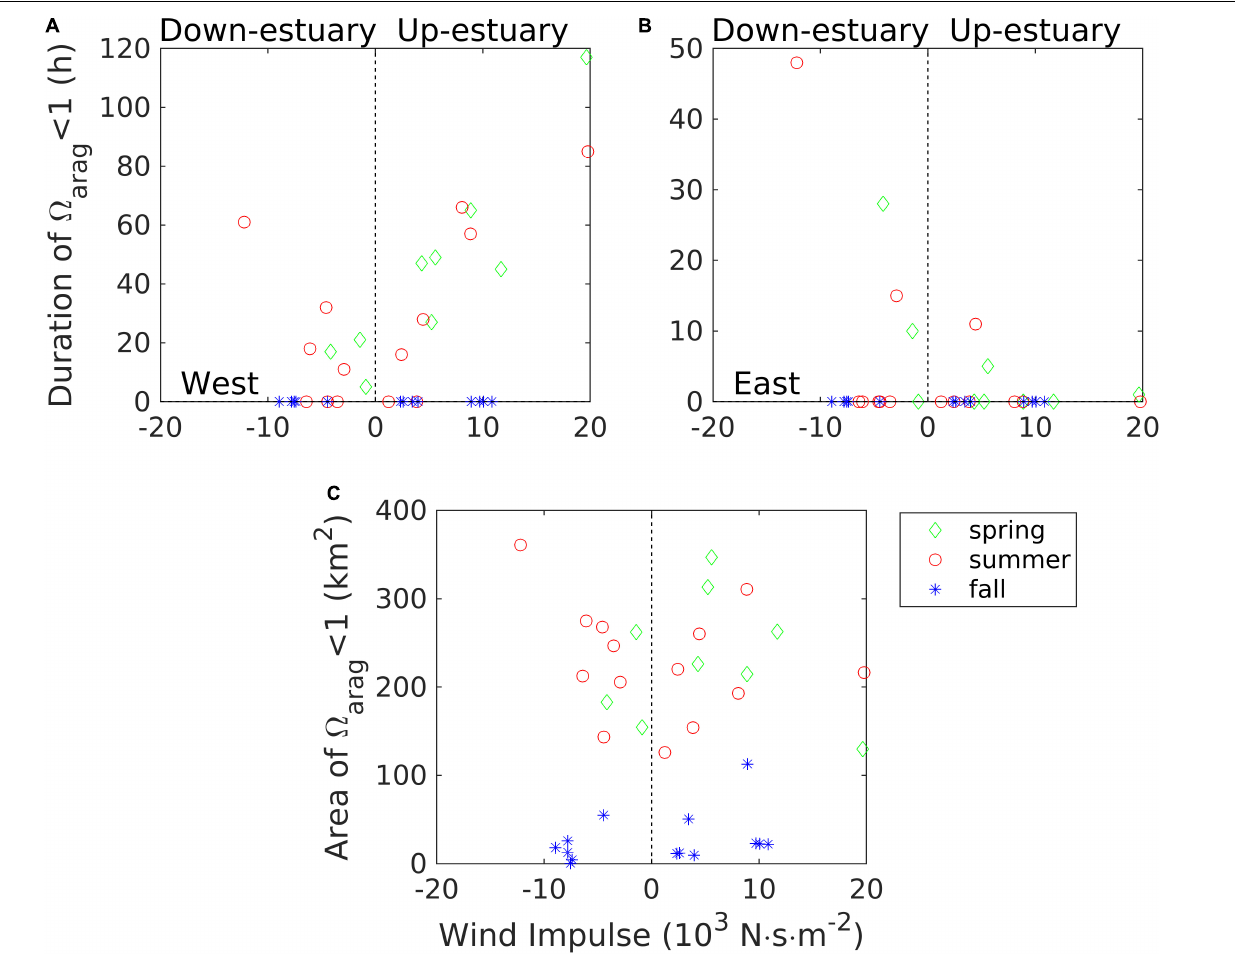
FIGURE 12 | Duration of aragonite saturation state (cid:127) arag < 1 in bottom waters at the western shoal (A) and the eastern shoal (B) locations in the mid-Bay cross-section. (C) The size of mainstem oyster beds in Maryland affected by under-saturated water ( (cid:127) arag < 1) during wind events. Green diamonds for spring, red circles for summer, and blue stars for